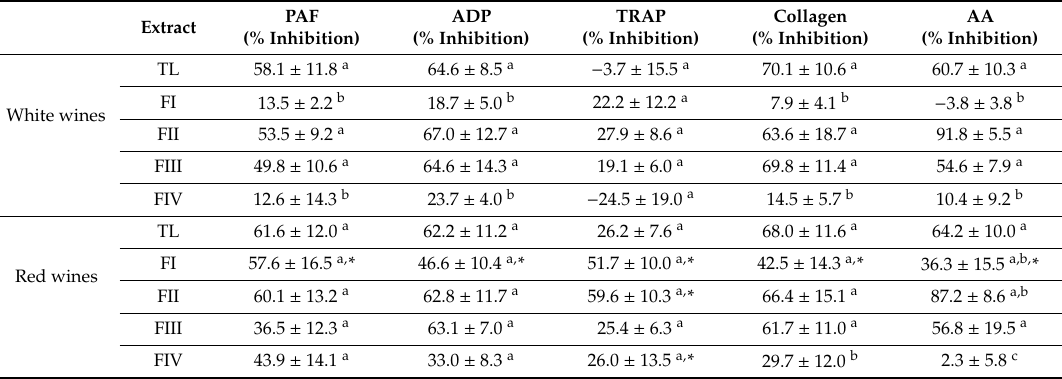
Table 3. Anti-platelet activity of wines per type of extract and per color of wine. PAF ADP TRAP Collagen Extract (% Inhibition) (% Inhibition) (% Inhibition) (% Inhibition)